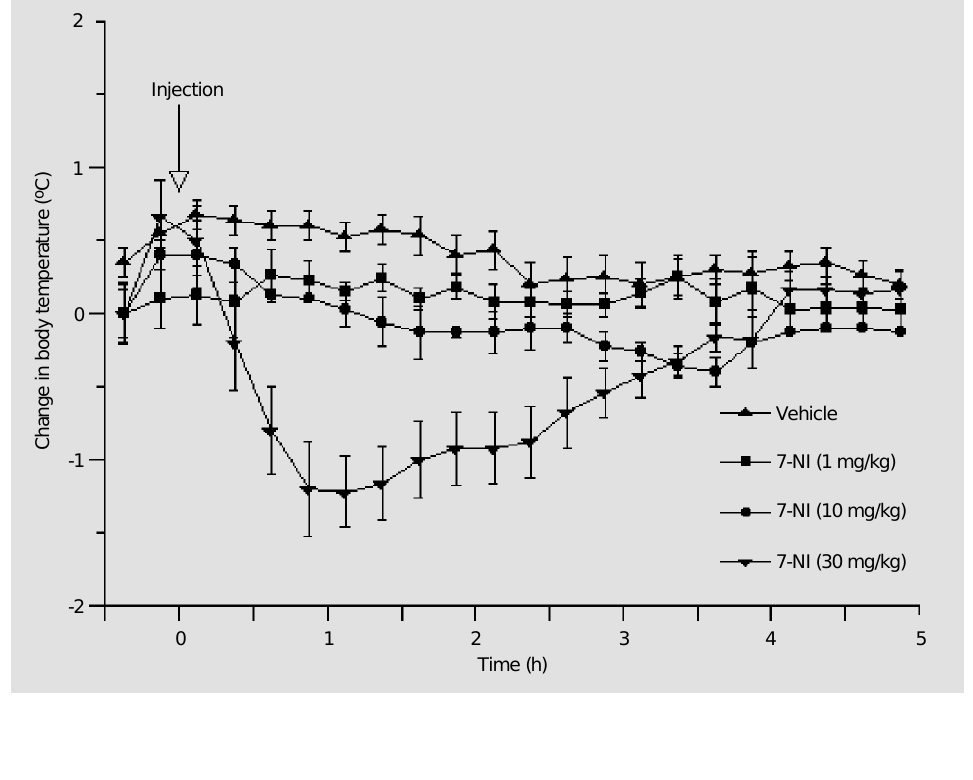
Figure 3 - Body temperature of rats injected with 100 µg/kg lipo- polysaccharide (LPS) combined with 30 mg/kg N G -nitro-L-argi- nine methyl ester (L-NAME) and with 30 mg/kg 7-nitroindazole (7- NI) compared to rats that re- ceived only LPS. Data are re- ported as mean changes in tem- perature (± SEM) determined at 15-min intervals relative to base- line. N = 5 in each